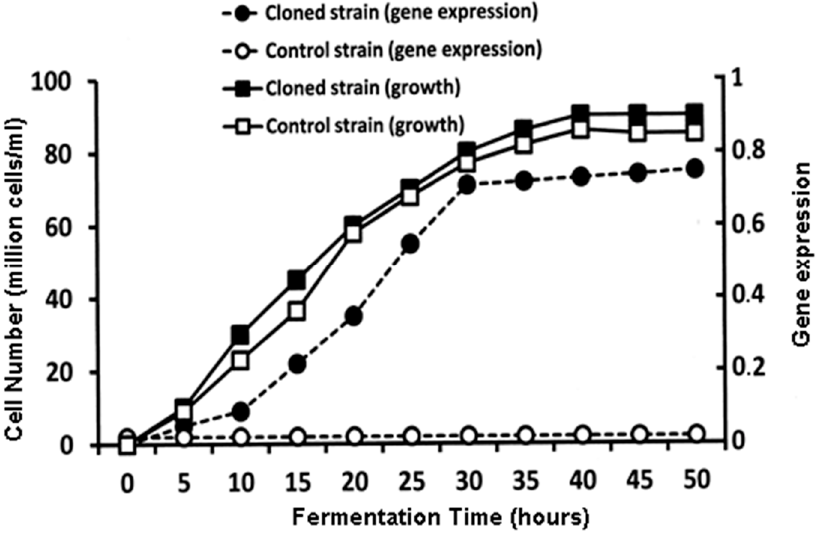
Figure 11. Expression of the ATF1 gene during fermentation. Cells cultured (with shaking) in yeast extract–peptone–glucose medium at 21 °C. Control strain (growth) ( □ ); cloned strain (growth) ( ● ); control strain (gene expression) ( ○ ); cloned strain (gene expression) ( ) [54].